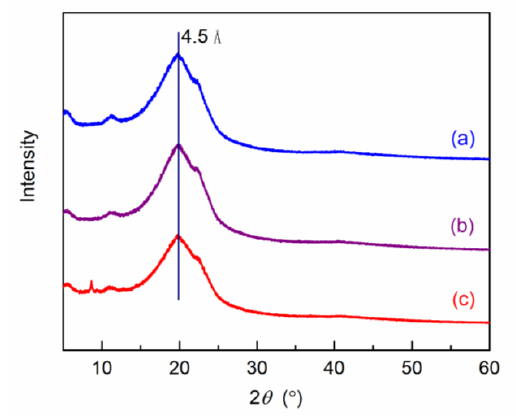
Figure 3. XRD spectra of Pebax-2533 membrane ( a ), 0.6 wt% T( p -OCH 3 )PPCoCl/Pebax-2533 / Pebax-2533 membrane ( c membrane ( b ), and 2 wt% T( p -OCH 3 )PPCoCl/Pebax-2533 membrane ( c ). ( b ), and 2 wt % T( p -OCH 3 )PPCoCl